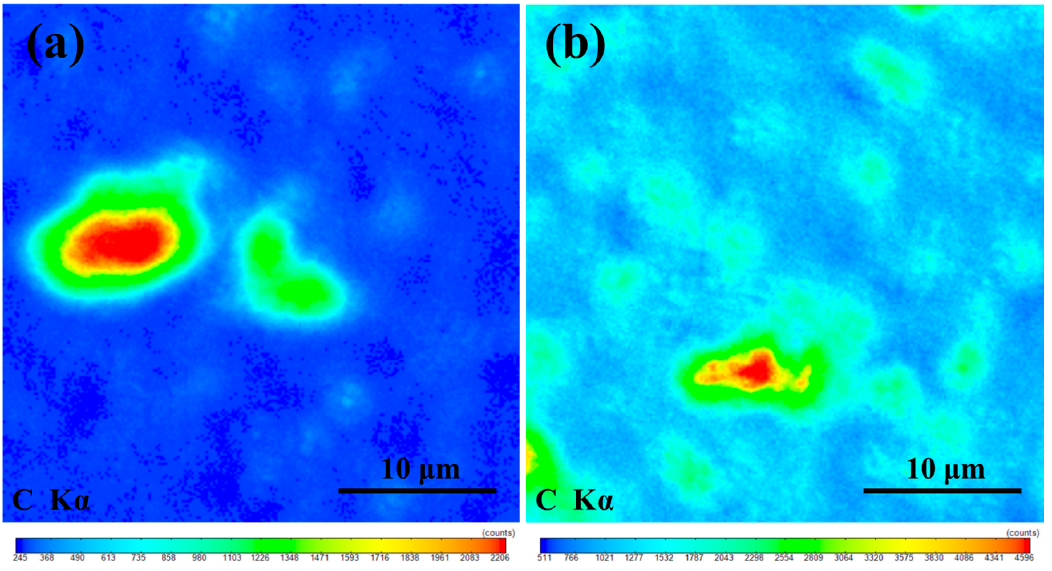
Figure 5. EPMA element mapping results of ( a ) 0.1 M and ( b ) 2 M for carbon.